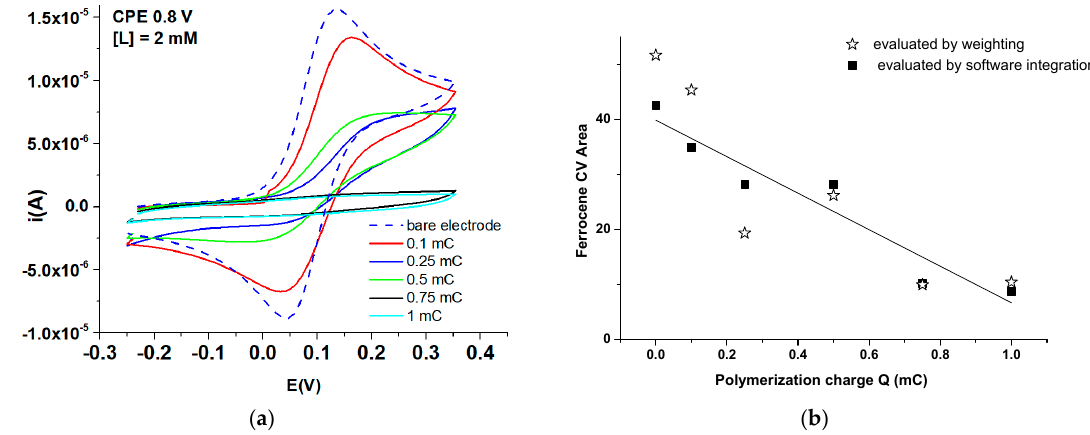
Figure 9. CV (0.1 V / s) curves in ferrocene solution (1 mM in 0.1M TBAP / CH 3 CN) of poly L -modified Figure 9. CV (0.1 V/s) curves in ferrocene solution (1 mM in 0.1M TBAP/CH 3 CN) of poly L ‐ modified electrodes prepared by CPE at + 0.8 V in L solution (1 mM) in 0.1 M TBAP / CH 3 CN using di ff electrodes prepared by CPE at +0.8 V in L solution (1 mM) in 0.1 M TBAP/CH 3 CN using different electropolymerization charges ( a ) and dependence of the of peak area on ferrocene (calculated by the